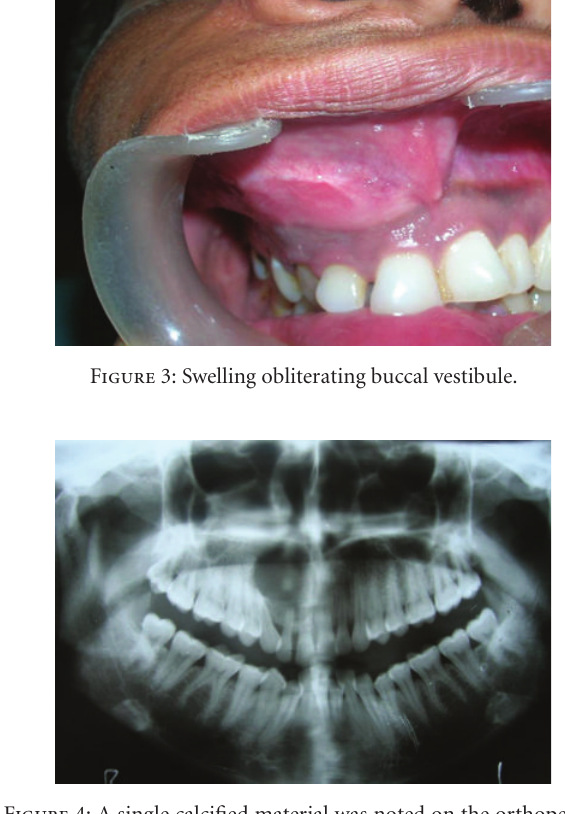
Figure 4: A single calcified material was noted on the orthopenta-